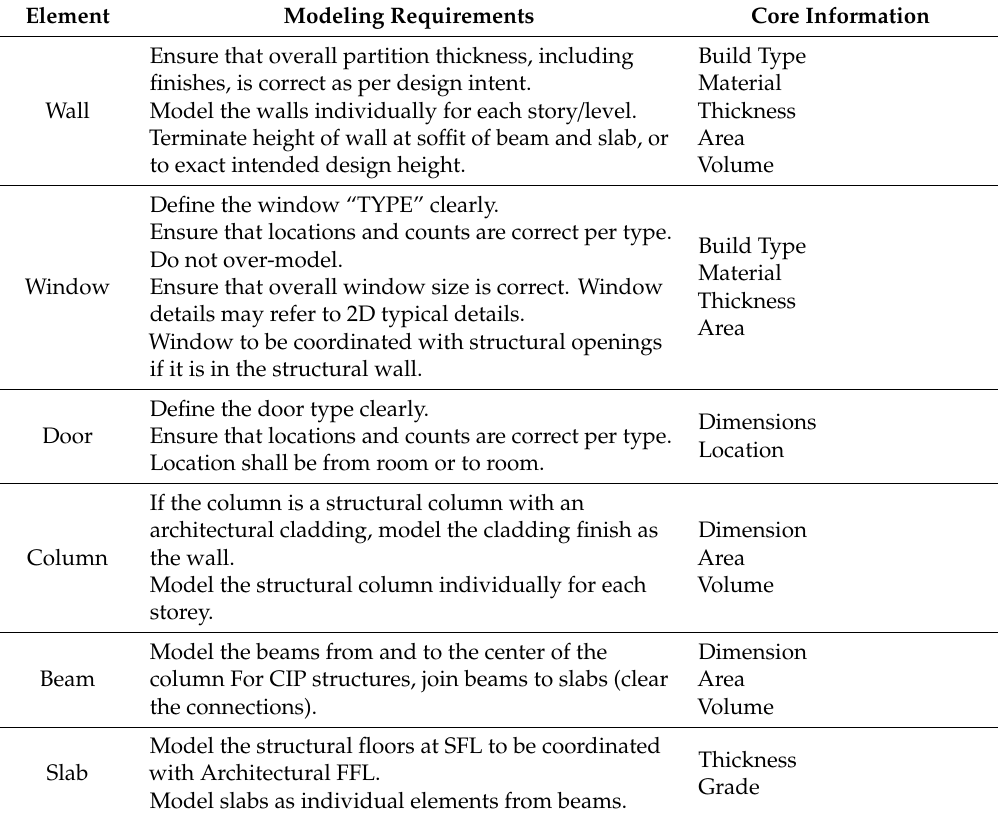
Table 2. Core information for thermal envelope performance